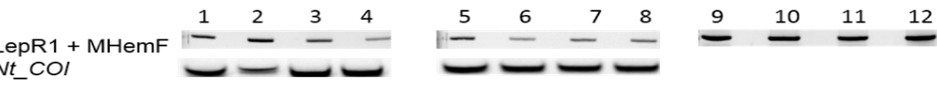
Figure 1. Amplification of the mtCOI gene using N. tenuis degenerate and specific DNA barcoding primers. Nesidiocoris tenuis from Spain (samples 1–4) and Texas (samples 5–8), and outgroup B. cockerelli (samples 9–12).